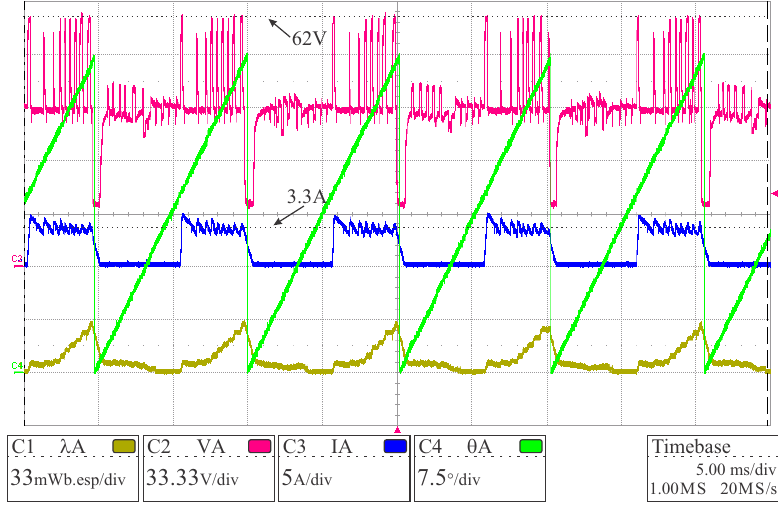
Figure 13. Experimental results with the proposed drift cancellation